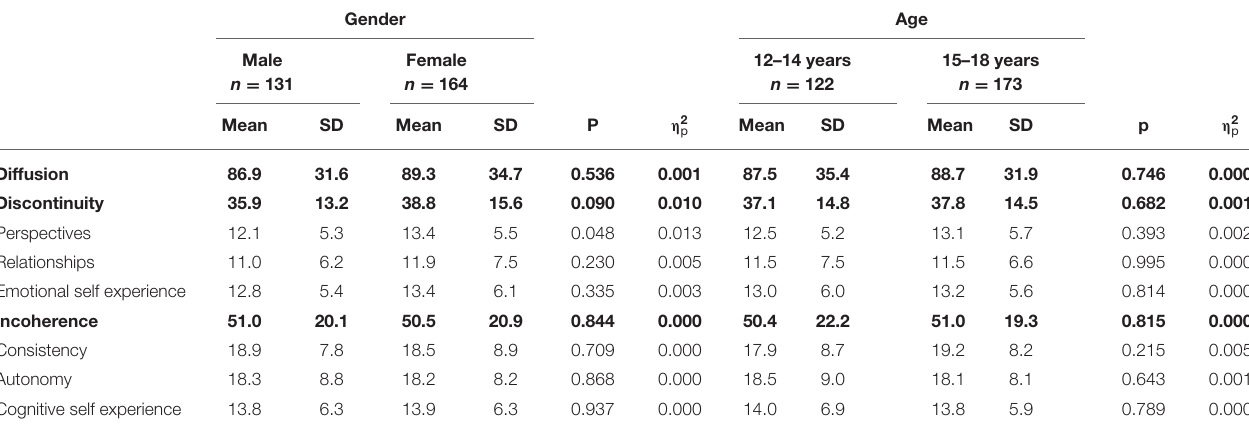
TABLE 6 | Differences in AIDA mean scores (mean) and standard deviations (SD) between younger and older adolescents and between boys and girls in the school sample significance (p) and effect size partial eta-square ( η 2 p ) of the differences. Gender Age Male Female n = 131 n = 164